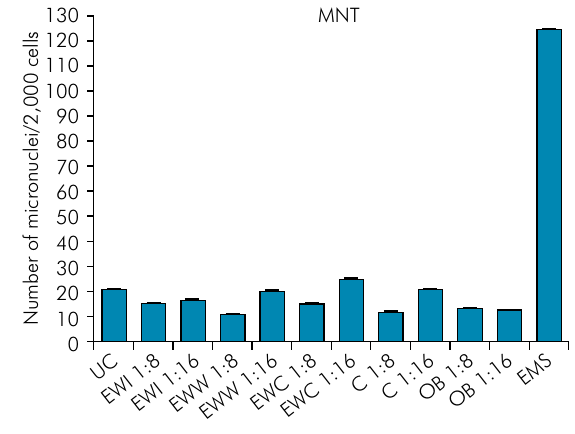
Figure 2. Induction of micronuclei in gingival fibroblasts after exposure to toothpastes. The micronuclei induced by the toothpastes were obtained from five treated cell cultures, and bars represent medians (25th and 75th percentiles).